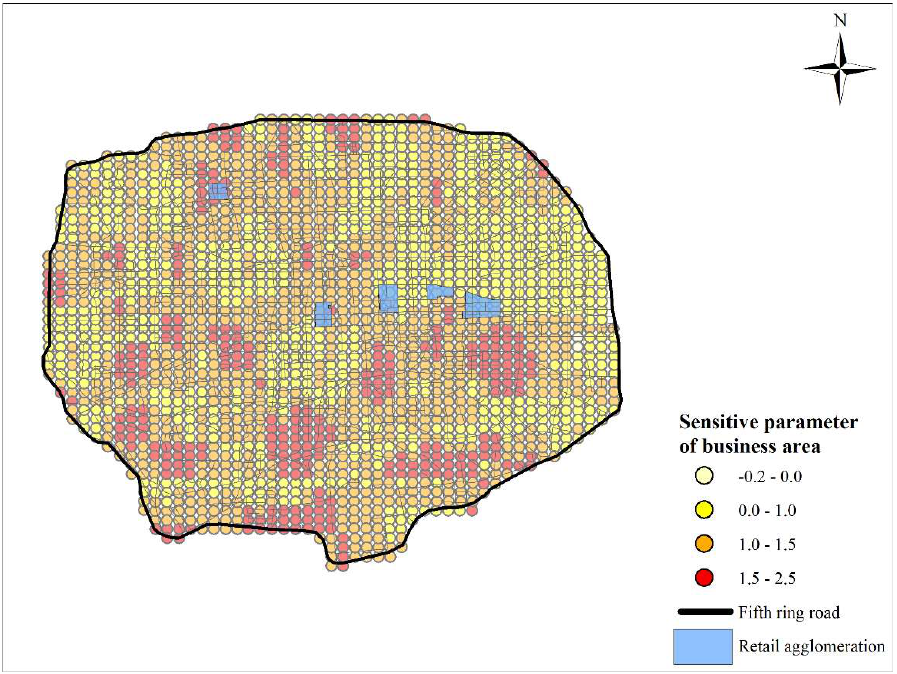
Figure 4. Spatial distribution of local sensitive parameters of business area. ISPRS Int. J. Geo-Inf. 2019 , 8 , x FOR PEER REVIEW